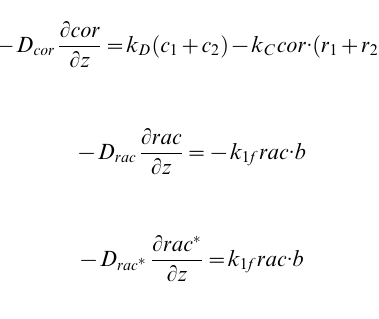
Table 1. Variables in the actin-wave model.